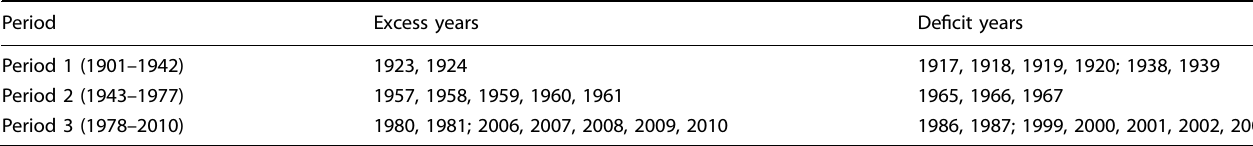
Table 1. Excess and de fi cit precipitation year for different